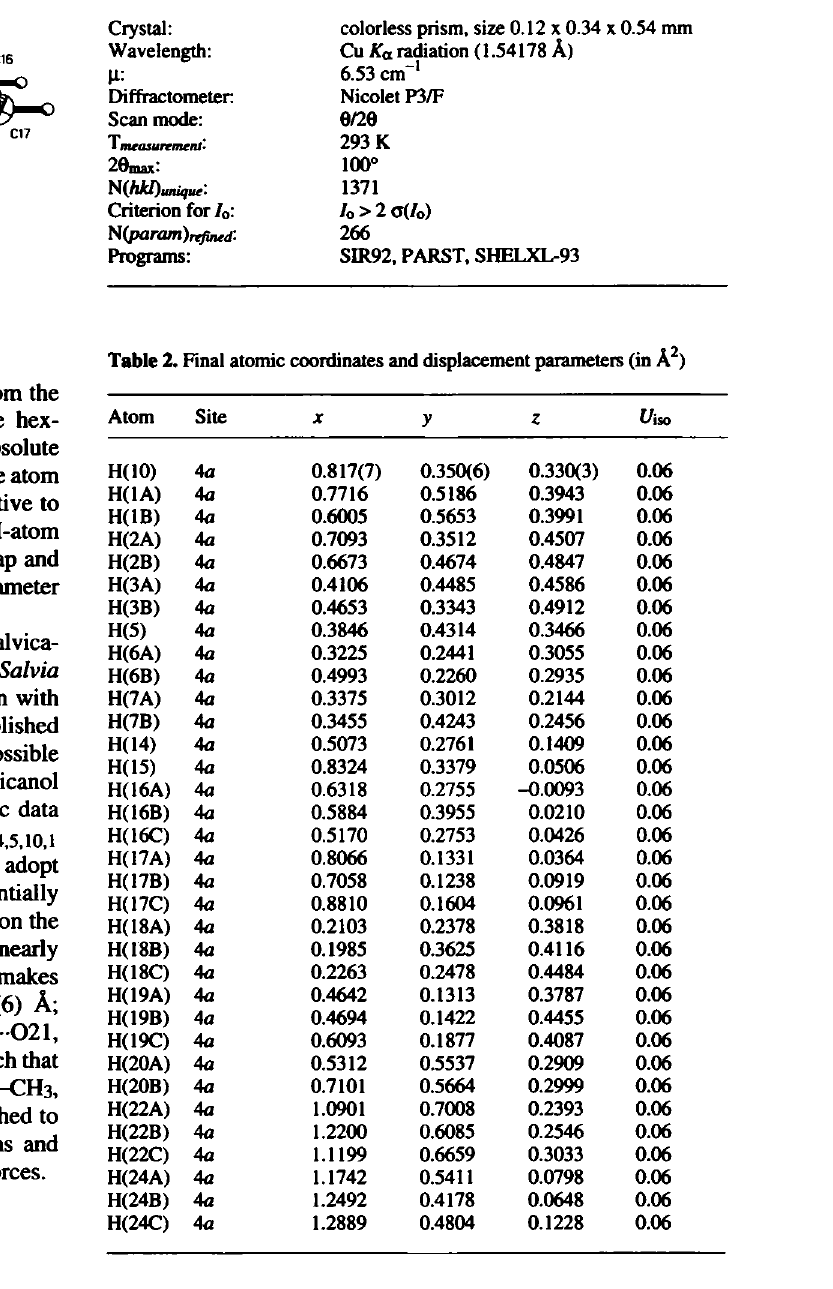
Table 1. Parameters used for the X-ray data collection